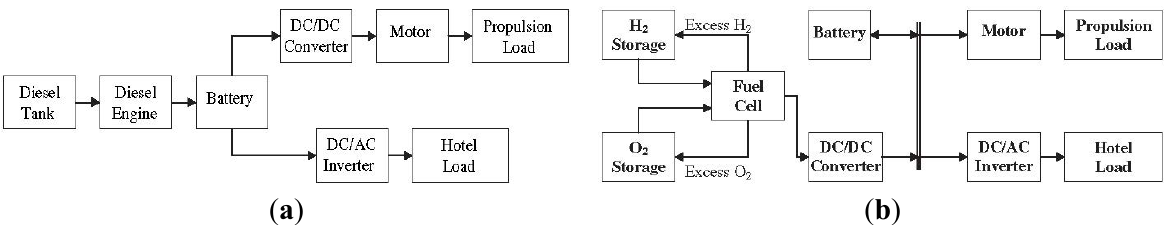
Figure 8. Schematic diagram for the ( a ) conventional battery based system and (b ) fuel cell/battery-based system. Reprinted with permission from reference [107].